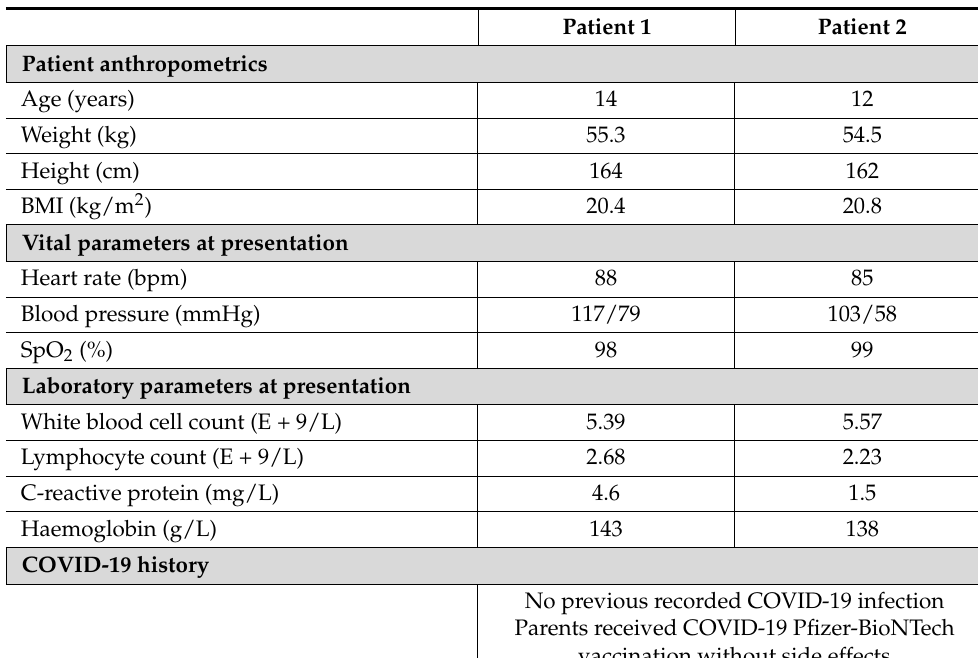
Figure 3. Comparison of trends in hs-Troponin T during the acute phase of myocarditis. Table 1. Demographics and laboratory findings.